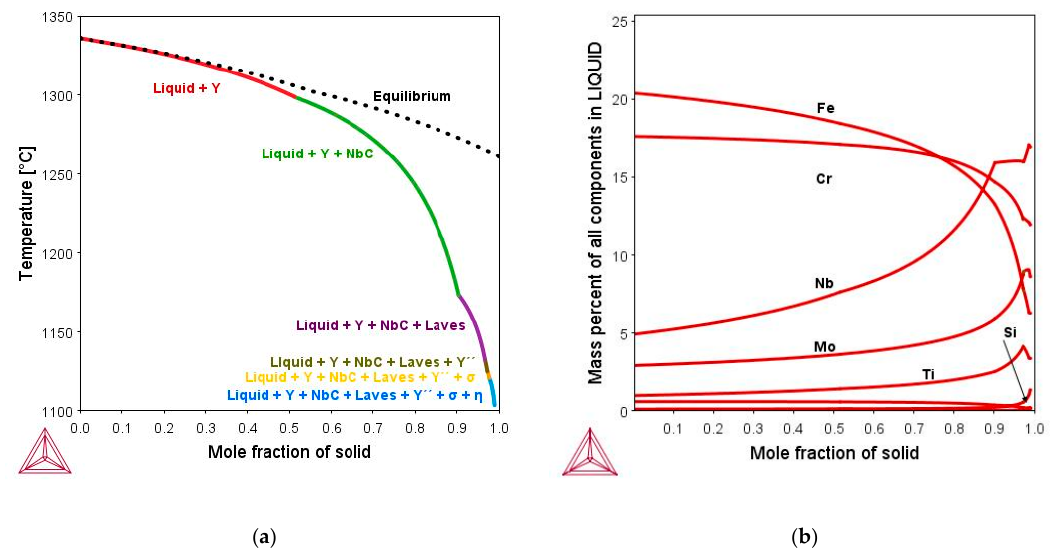
Figure 17. Thermo-Calc simulation of alloy E (standard Si content): ( a ) solidification path and ( b ) microsegregation prediction using the Scheil